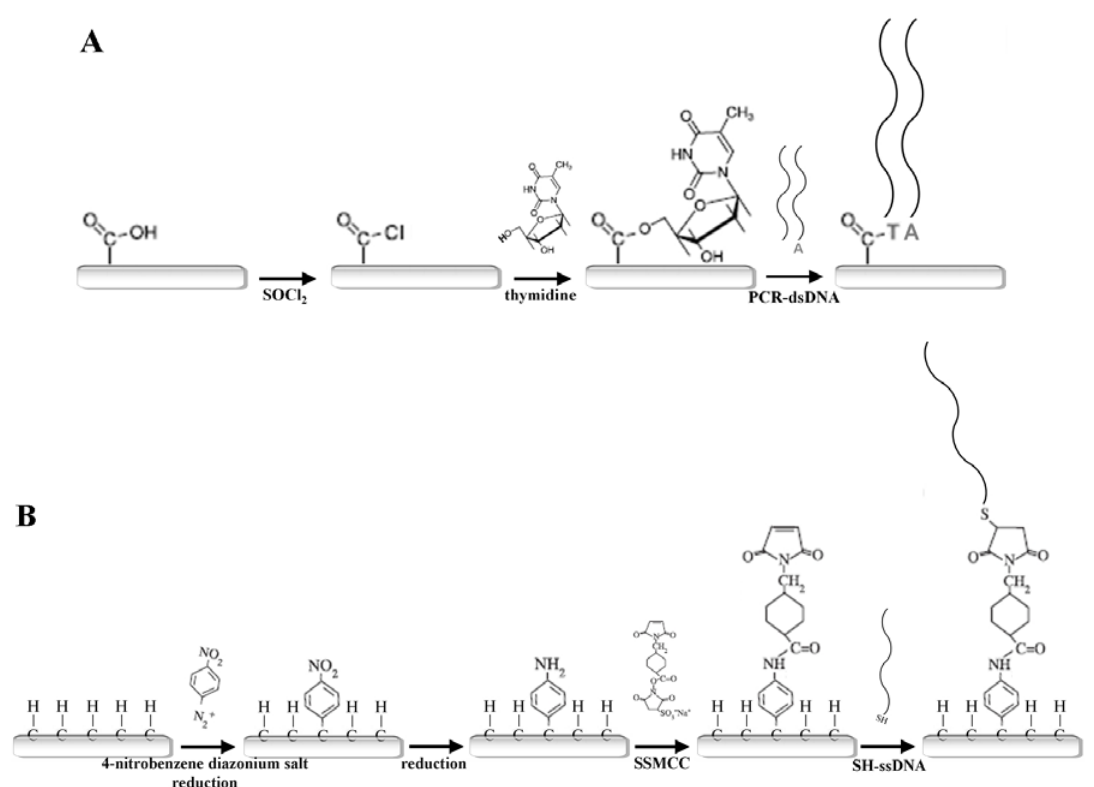
Figure 11. Different reaction mechanisms for the covalent attachment of DNA to diamond. A: Reaction process used by Ushizawa and coworkers for the covalent attachment of PCR- amplified dsDNA to thymidine-modified diamond powder [28]. The surface of the diamond powder was oxidised and the carboxyl groups were subsequently modified with thymidine. DNA molecules generated through PCR amplification could be covalently ligated to the thymidine-modified surface. B: Reaction process used by Wang and coworkers for the covalent attachment of thiolated ssDNA to aminophenyl-modified p-type SCD [29]. The SCD was treated with a diazonium salt, which was subsequently reduced to nitrophenyl and attached to the SCD. The nitrophenyl groups were reduced to aminophenyl -modified SCD was modified with the cross-linker groups, and the resulting NH 2 sulphosuccinimidyl-4-(N-maleimido-mehyl)cyclohexane-1-carboxylate (SSMCC). Thiol (SH)-modified ssDNA could then be linked to the COOH-moiety of SSMCC. C: Reaction process used by Yang and coworkers for the covalent attachment of thiolated ssDNA to photochemically activated NCD [7]. H-terminated NCD surfaces were covalently modified with trifluoro-acetamide acid (TFAAD) under UV-illumination. The top trifluoro-acetic -modified NCD surfaces, to acid groups at the NCD surface were removed, forming NH 2 which SSMCC was bound. SH-modified ssDNA could then be linked to the COOH-moiety of SSMCC. D: Reaction process used by our group for the covalent attachment of aminated ssDNA to photochemically activated NCD [30,31]. H-terminated NCD surfaces were covalently modified with 10-unedecenoic acid (10-UDA) under UV-illumination. -modified DNA was then covalently bound to these COOH-groups through an amide NH 2 bond via 1-ethyl-3-(3-dimethylaminopropyl)-carbodiimide